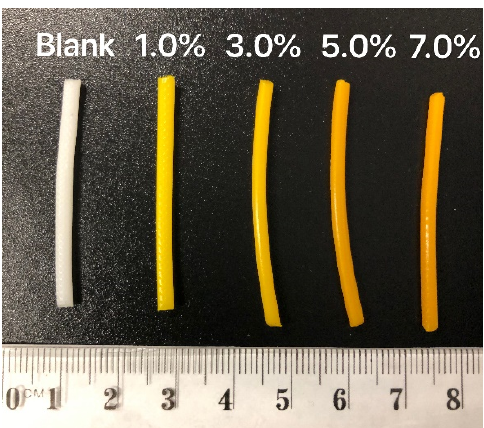
Figure 2. Blank and curcumin-loaded PCL filaments (1%, 3%, 5%, and 7%, w / w ).